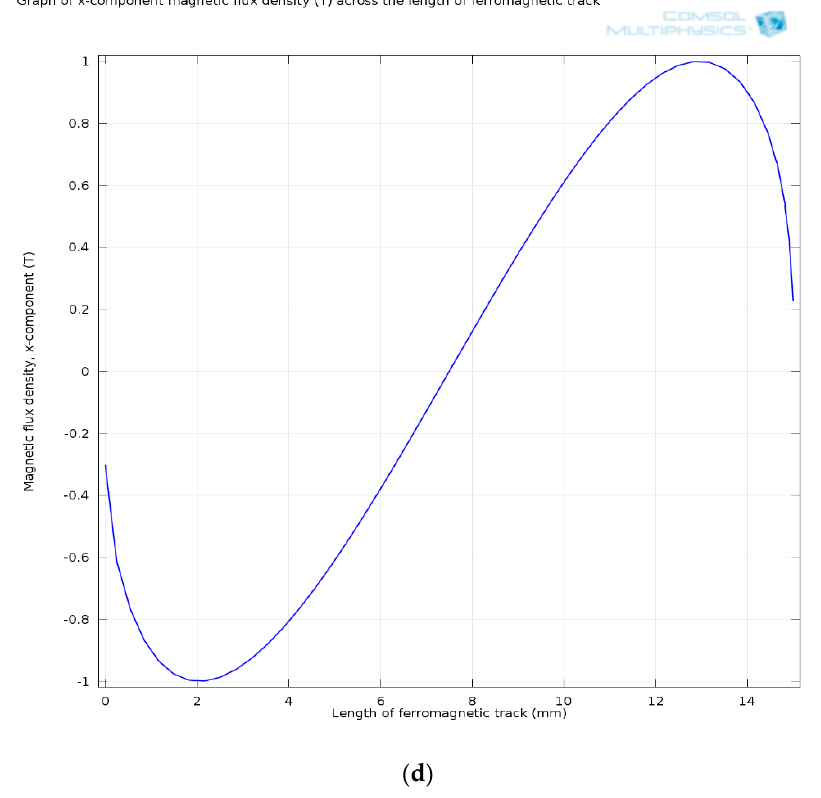
Figure 4. ( a ) Schematic of microchannel with ferromagnetic track (yellow region) in the MAP stage. Its magnetic flux density analysis is presented by the ( b ) surface plot. Graph of magnetic flux generated within the ferromagnetic track vs. the length of the track is plotted for: ( c ) y -component; ( d ) x -component.